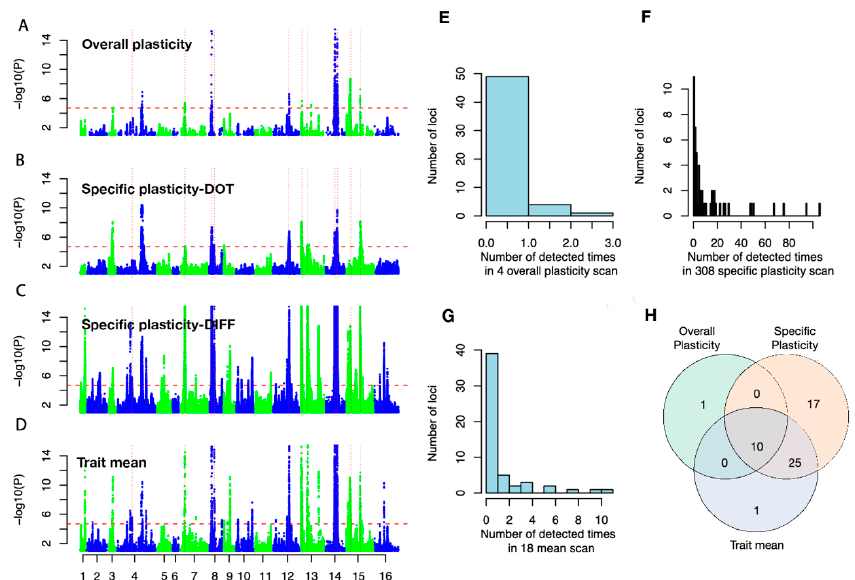
Figure 3. Summary of results from the association analyses of the plasticity measurements. ( A – D ) Manhattan plots overlaying the genome-wide association scans for the 4 overall plasticity measures (( A ), PCA1/PCA2/VAR/FWR), 154 specific plasticity measurements quantified as the pairwise dot product (( B ), DOT), the 154 specific plasticity quantified as pairwise difference (( C ), DIFF), and 18 trait means ( D ), respectively. The red horizontal dashed lines in ( A – D ) indicate the Bonferroni-corrected genome-wide significance threshold derived as 0.05/Me (Me is the effective number of independent single nucleotide polymorphisms, SNPs; Materials and Methods Section). SNPs with p -values below this threshold in ( A – D ) were declared to be statistically significant. ( E – G ) The total number of times a QTL is detected in the overall plasticity, pairwise plasticity, and trait mean GWA scans. ( H ) The overlap between QTL detected for overall plasticity, pairwise plasticity, and trait